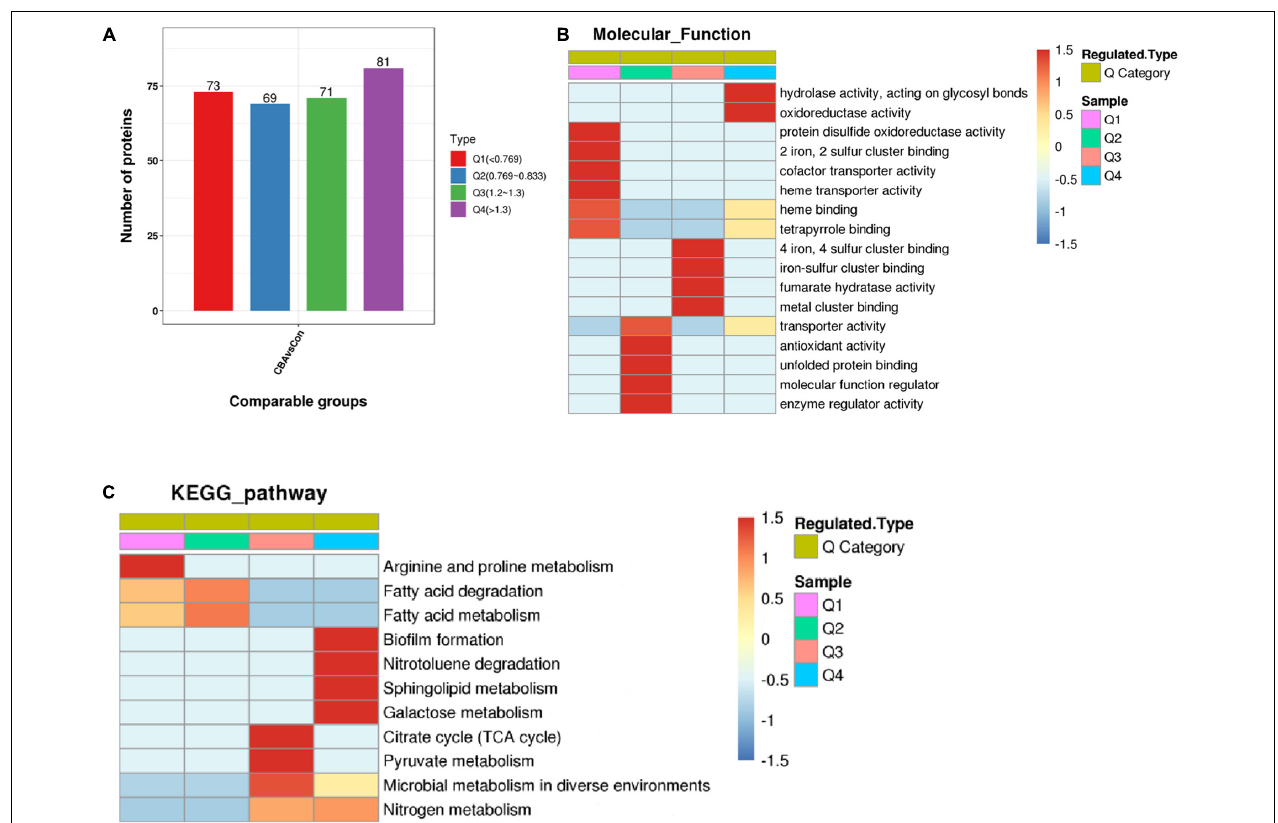
FIGURE 5 | Enrichment-based clustering analysis. The differentially expressed proteins were divided into four parts: Q1 ( < 0.769), Q2 (0.769–0.833), Q3 (1.2–1.3), and Q4 ( > 1.3) according to differential expression multiple (A) . Hierarchical clustering based on functional classification of differentially expressed proteins (Molecular Function) (B) and KEGG Pathway based on Escherichia coli K-12 MG1655 (C) . Color from blue to red represents the degree of enrichment from weak to strong,